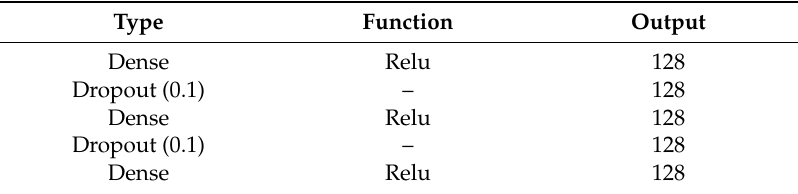
Table 6. Base models for Siamese networks.